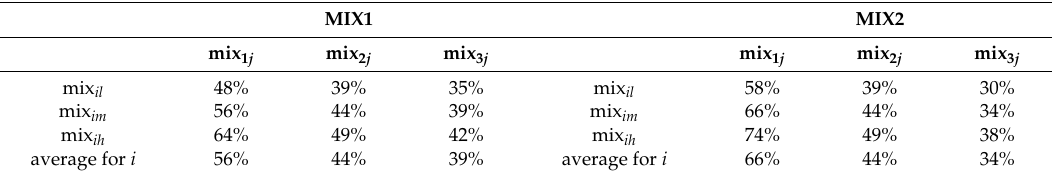
Table A14. Percentage increase in the dental charges necessary to maintain markup (of the mixes and therefore totaled) constant for the 9 mixes under consideration in the two mix scenarios (MIX1 and